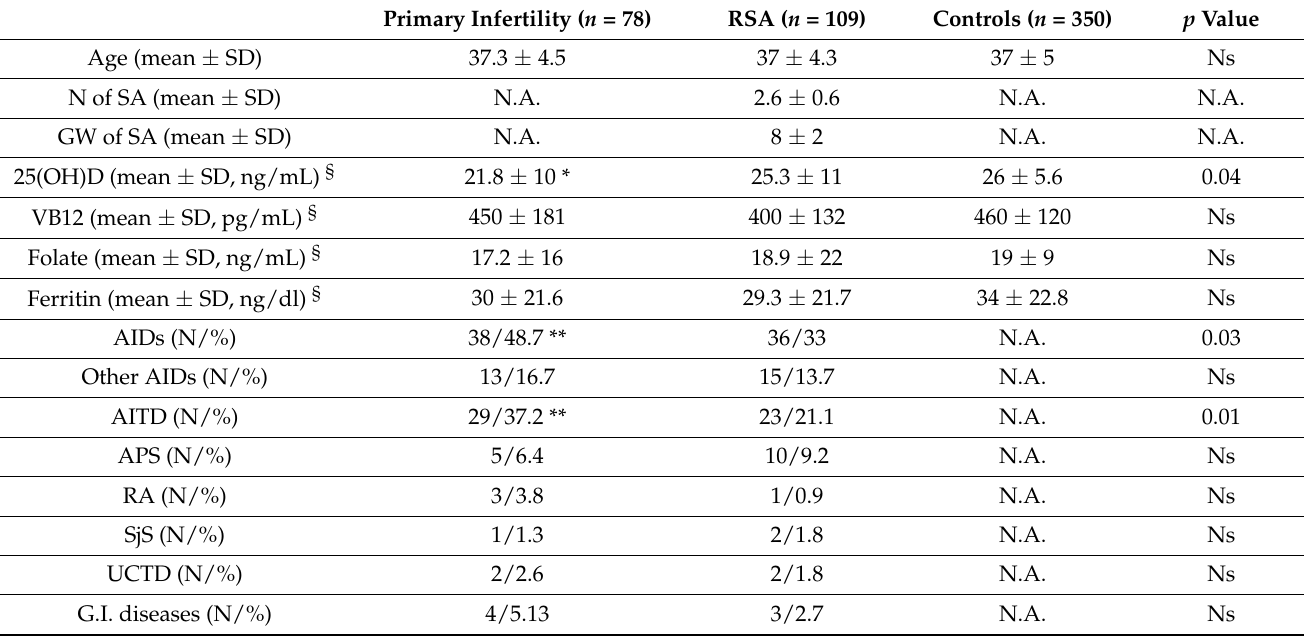
Table 1. Data from women with infertility and recurrent spontaneous